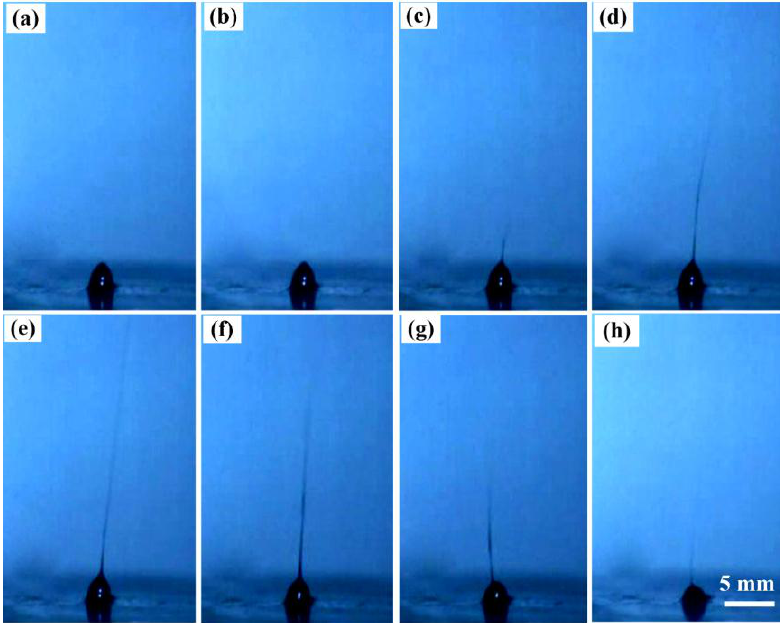
Figure 2. Needleless electrospinning process captured by a high-speed camera. (a) Self-assembling of ferrofluid, (b) formation of Taylor Cone, (c) onset of jet emission, (d–f) electrospinning process, (g,h) diminution of needless electrospinning. All the subfigures share the same scale